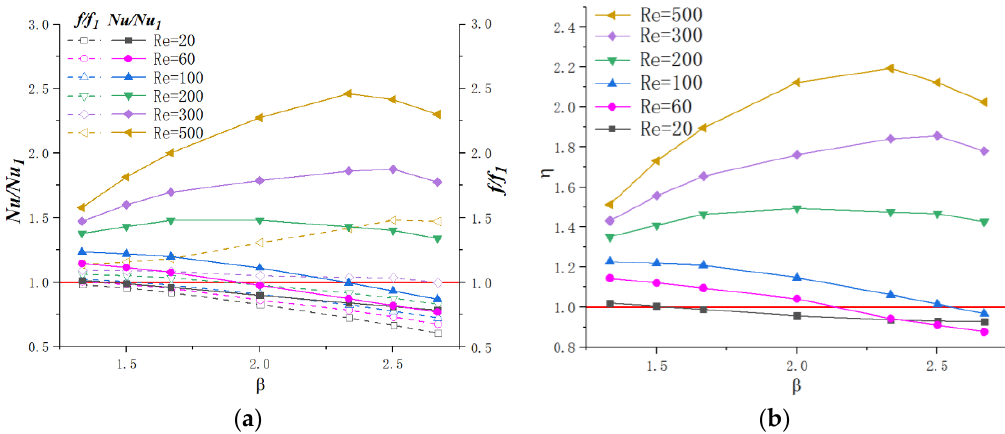
Figure 17. Variation of f/f 1 , Nu/Nu 1 and ƞ with 𝛽 for different Reynolds number. ( a ) f / f 1 , Nu / Nu 1 , ( b ) ƞ.